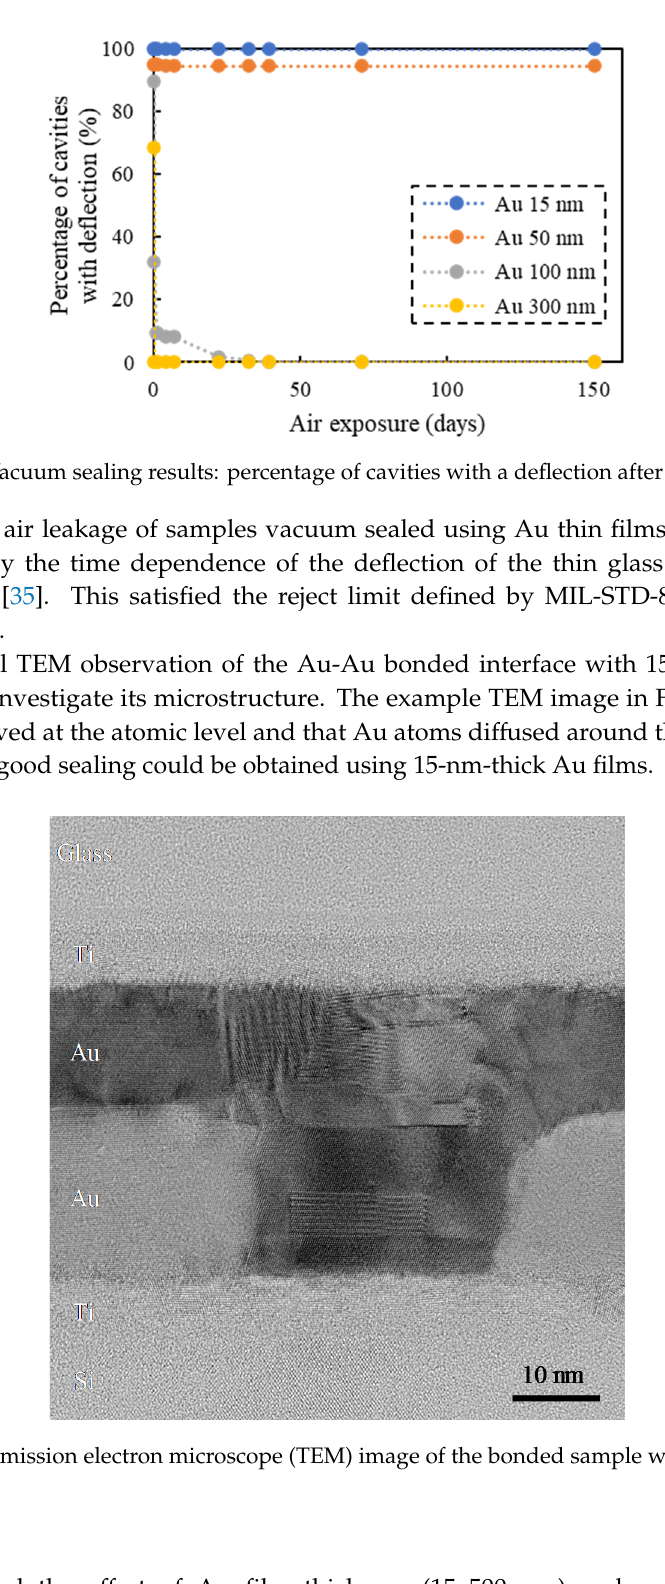
Figure 15. Transmission electron microscope (TEM) image of the bonded sample with a 15-nm-thick Au film.